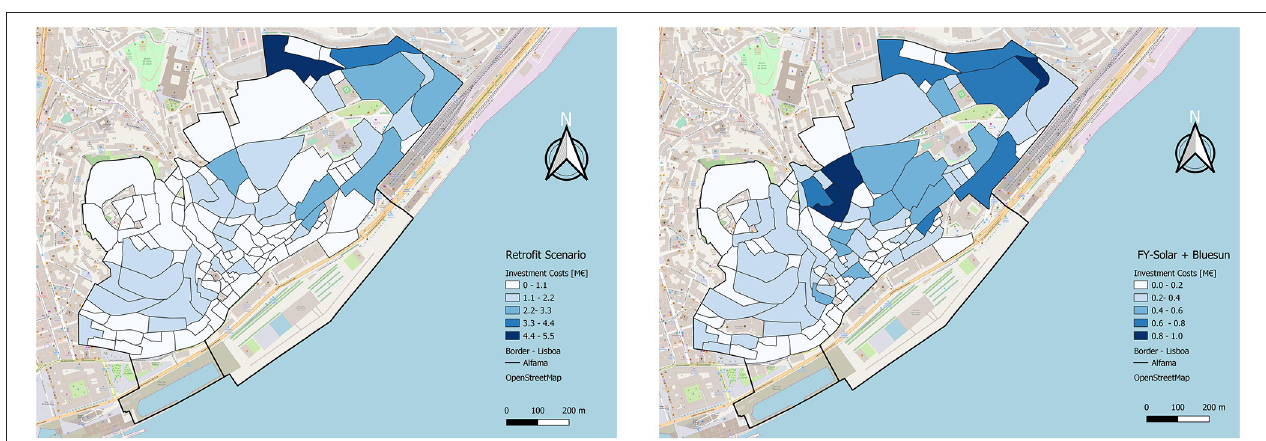
FIGURE 8 | Investment costs needed for full buildings retrofit (left) and solar PV integration (right) in Alfama subsections.